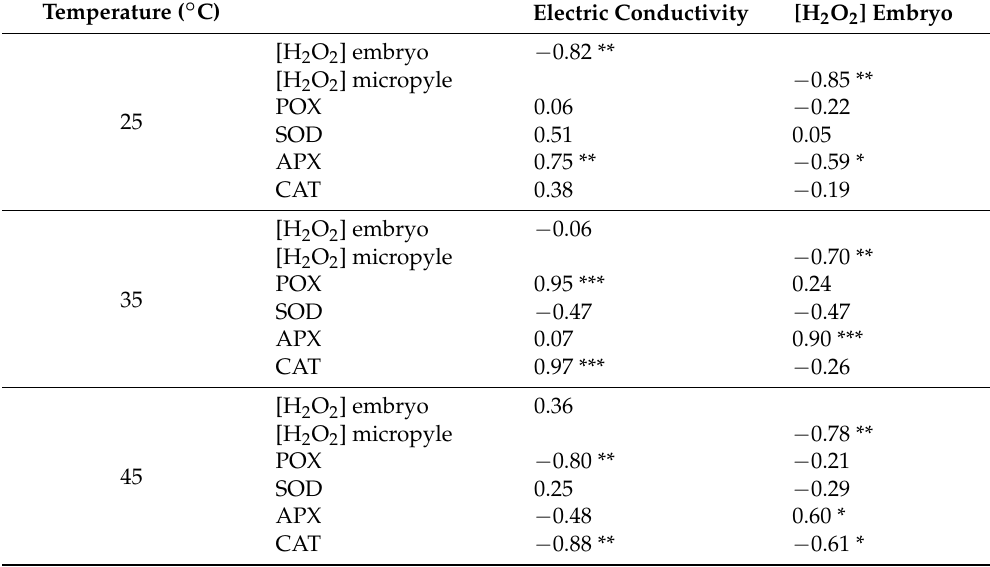
Table 1. Pearson correlation coefficients for means of electric conductivity (EC), concentration of hydrogen peroxide in the embryo and micropylar endosperm, and activity of the enzymes peroxidase (POX), superoxide dismutase (SOD), ascorbate peroxidase (APX), and catalase (CAT) in Melanoxylon brauna seeds germinated after soaking at 25, 35, and 45 ◦ C. Temperature ( ◦ C) Electric